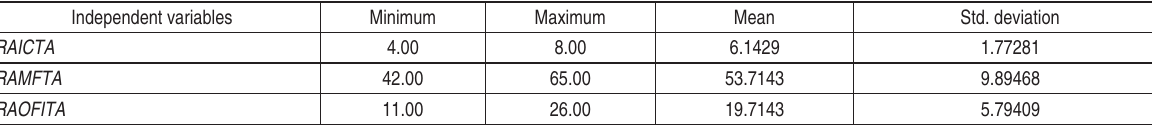
Table 1 (cont.). The statistical descriptive analysis of independent variables